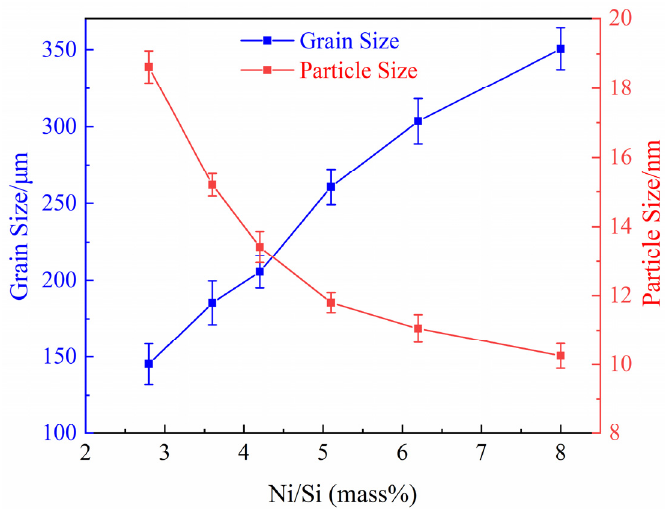
Figure 14. Variation curves of average grain and particle size of alloys with di ff erent Ni / Si mass ratios.